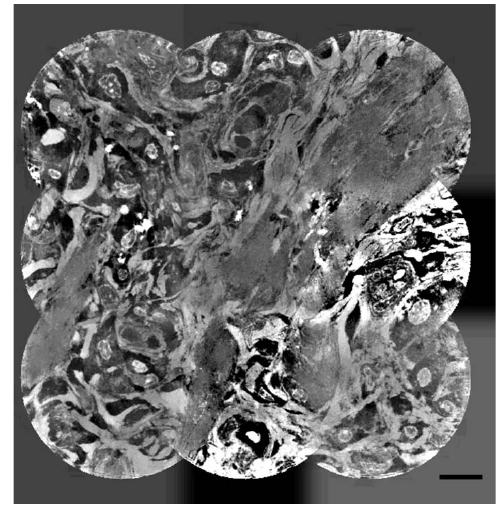
Figure 4 Slice of a stitched volume of a rat lung. The volume was obtained from 27 individual scans with a step size of 35 m m. The scale bar indicates 10 m